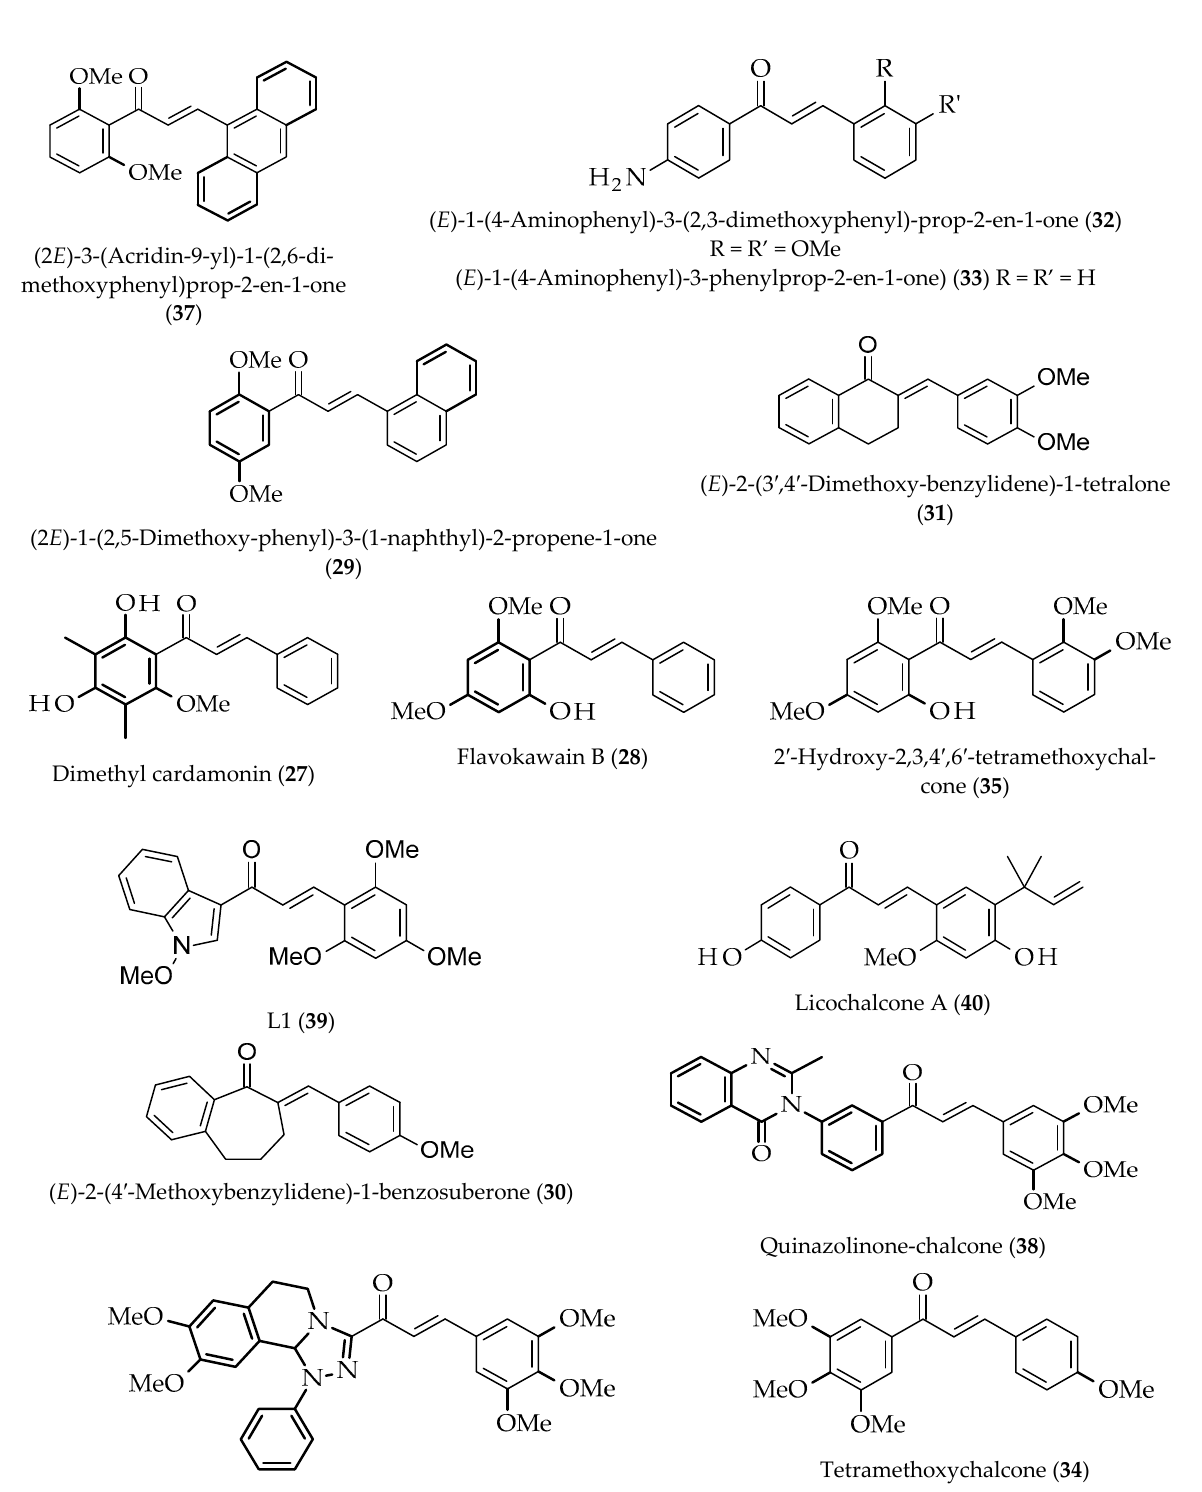
Figure 6. Structures of some chalcones that interfere with the cell cycle.